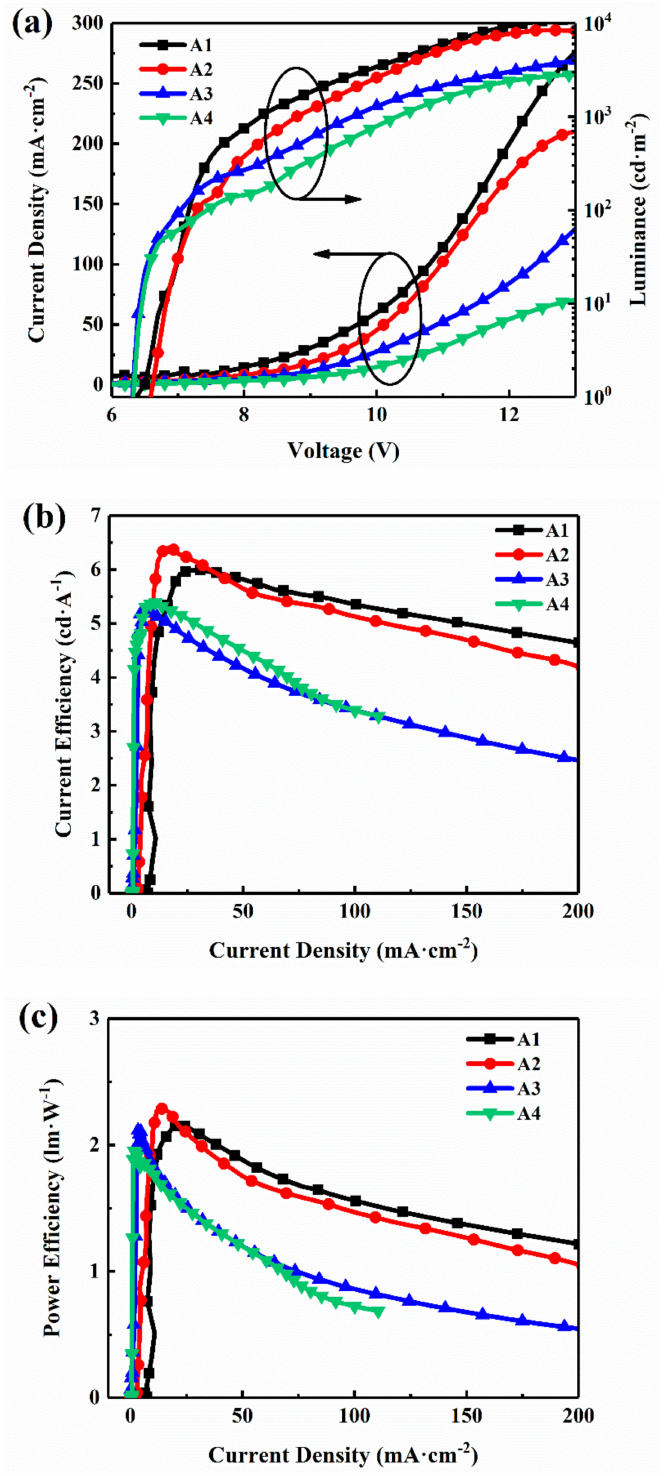
Figure 3. The performances of devices. ( a ) The current density–luminance–voltage (J–L–V) characteristics, ( b ) the current efficiency–current density (CE–J) characteristics, ( c ) the power efficiency–current density (PE–J)